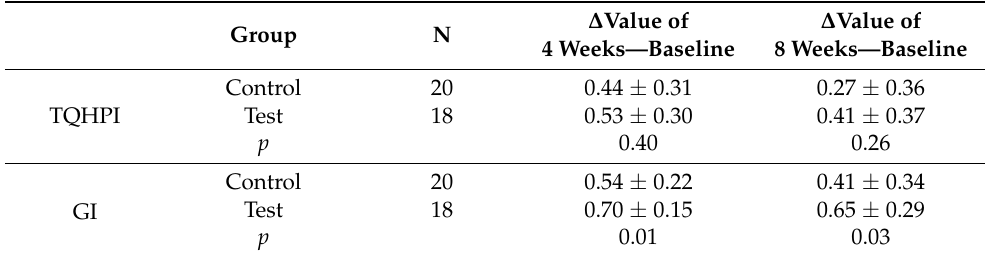
Table 2. Difference values of before and after treatment in PI and GI. Mean ± SD. ∆ Value of Group N